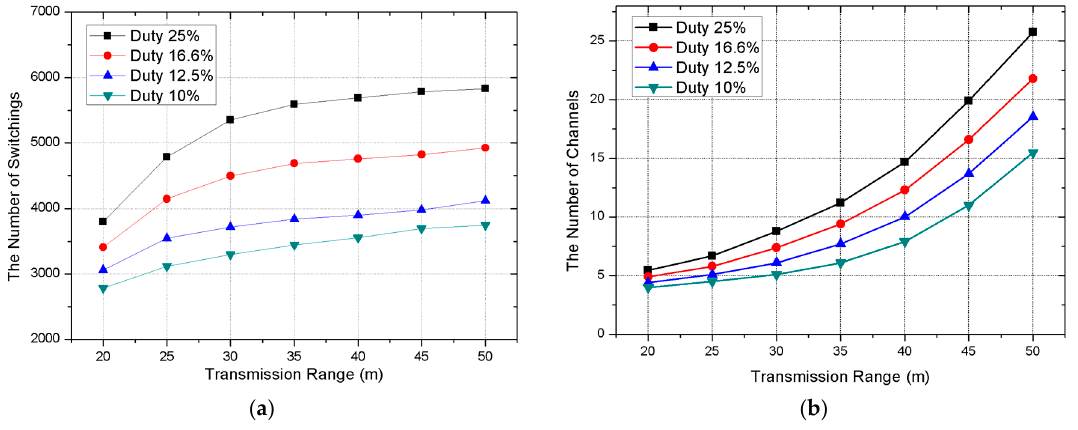
Figure 10. ( a ) The number of channels required according to the duty period; and ( b ) the number of channel switches according to the duty period.